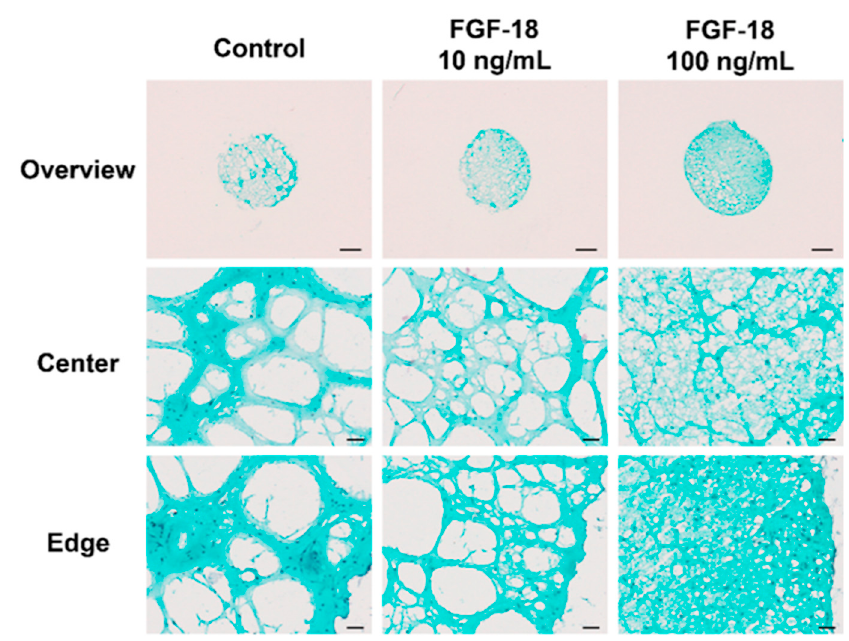
Figure 6. Representative Safranin O/Fast Green-stained transverse sections of human (mildly degenerated) nucleus pulposus cells encapsulated in FBG-HA hydrogel and stimulated with 0, 10, or 100 ng/mL FGF-18 after 14 days of culture. Scale bar: overview—1000 µm, center and edge—50 µm.